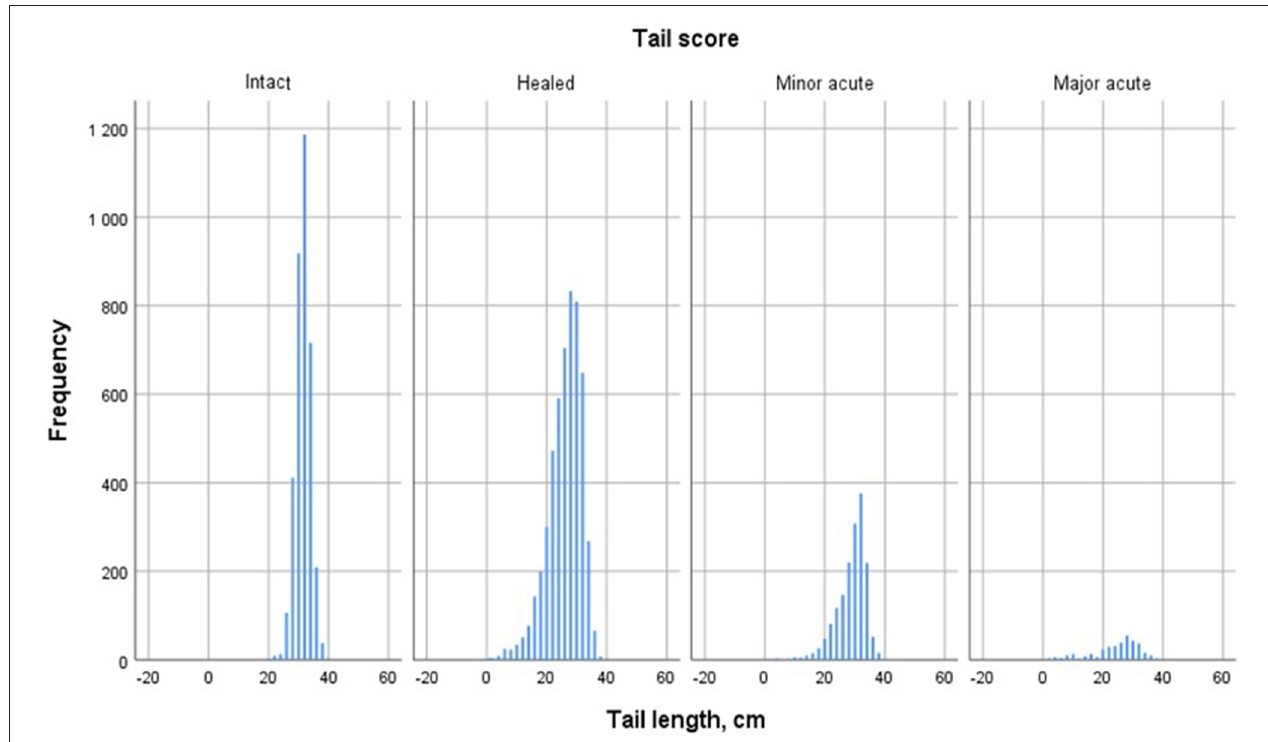
FIGURE 2 | Distribution of tail lengths in finishing pigs with different lesion scores, measured after the entire scalding process at the slaughter line ( n = 10 889).